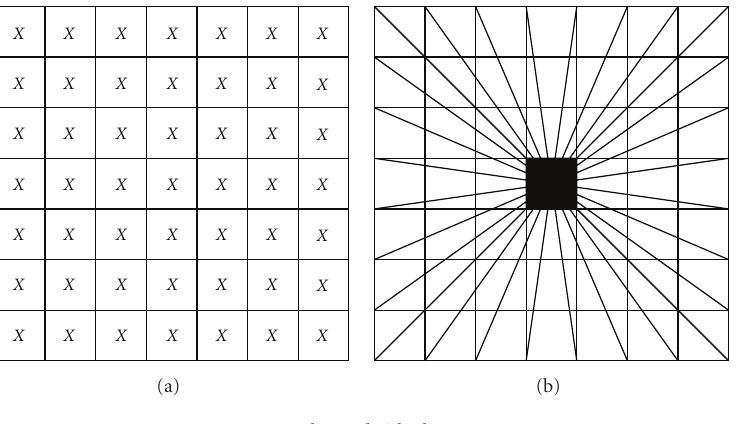
Figure 6: Wavelet and ridgelet parameters.